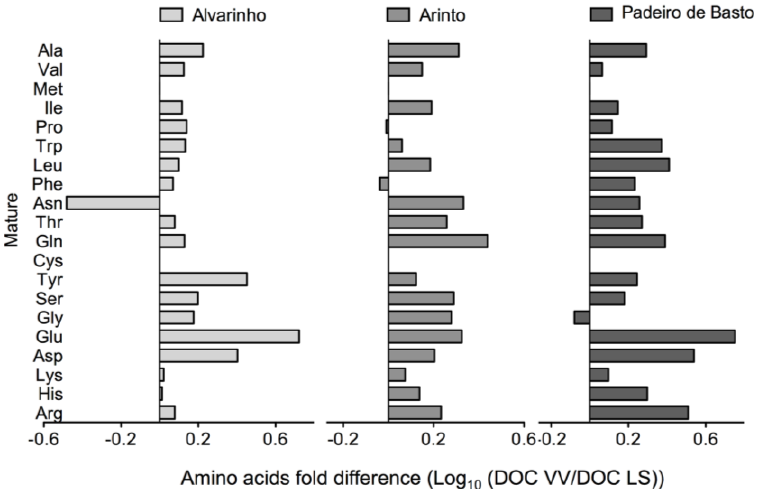
Figure 5. Free amino acid content in grape berries from Alvarinho, Arinto and Padeiro de Basto cultivated in the DOC VV and DOC LS regions. Values of 19 amino acid concentrations at the mature stage are the logarithmic transformed fold change (DOC VV/DOC LS) of berries from Alvarinho, Arinto and Padeiro de